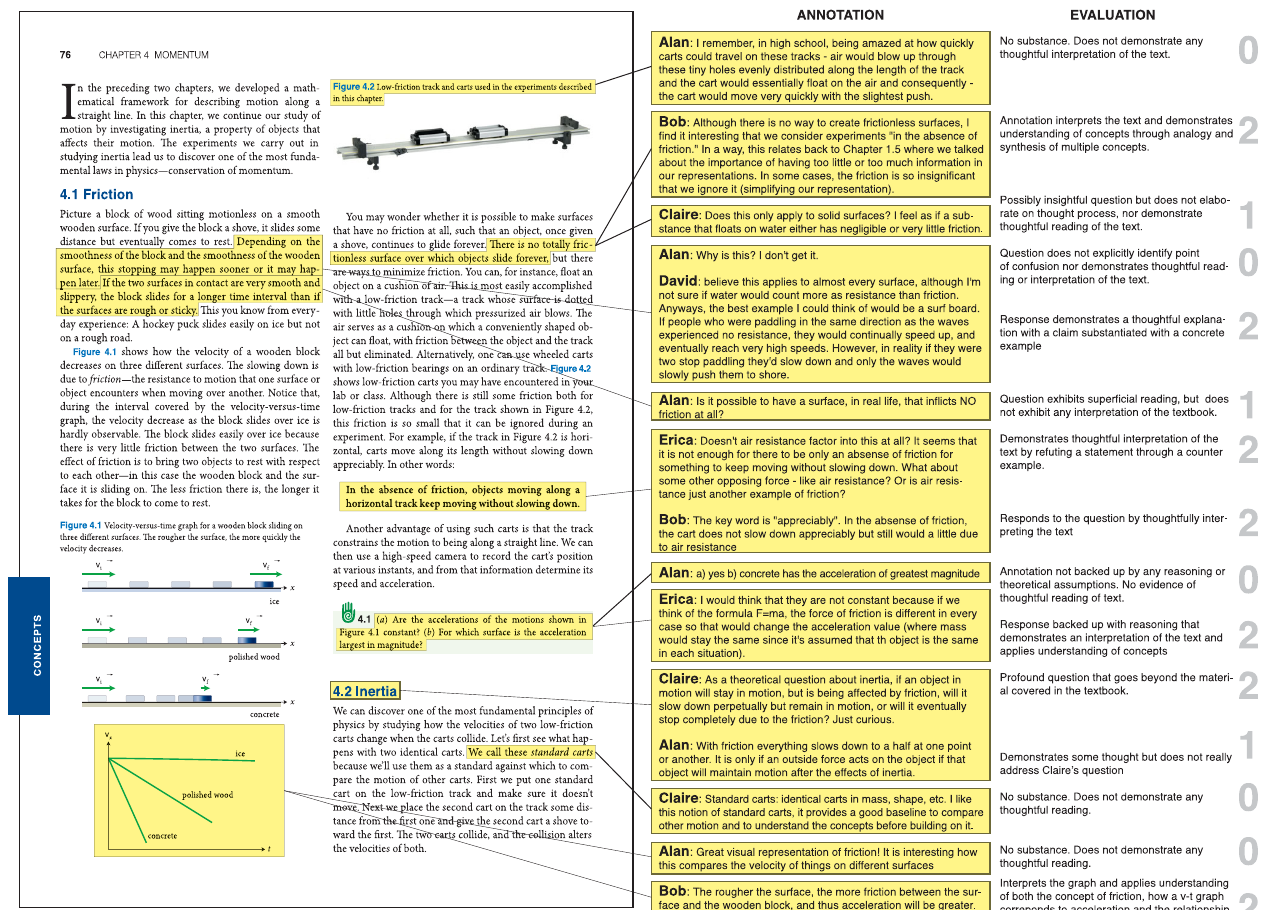
FIG. 1. Examples of annotations, scores, and justifications for